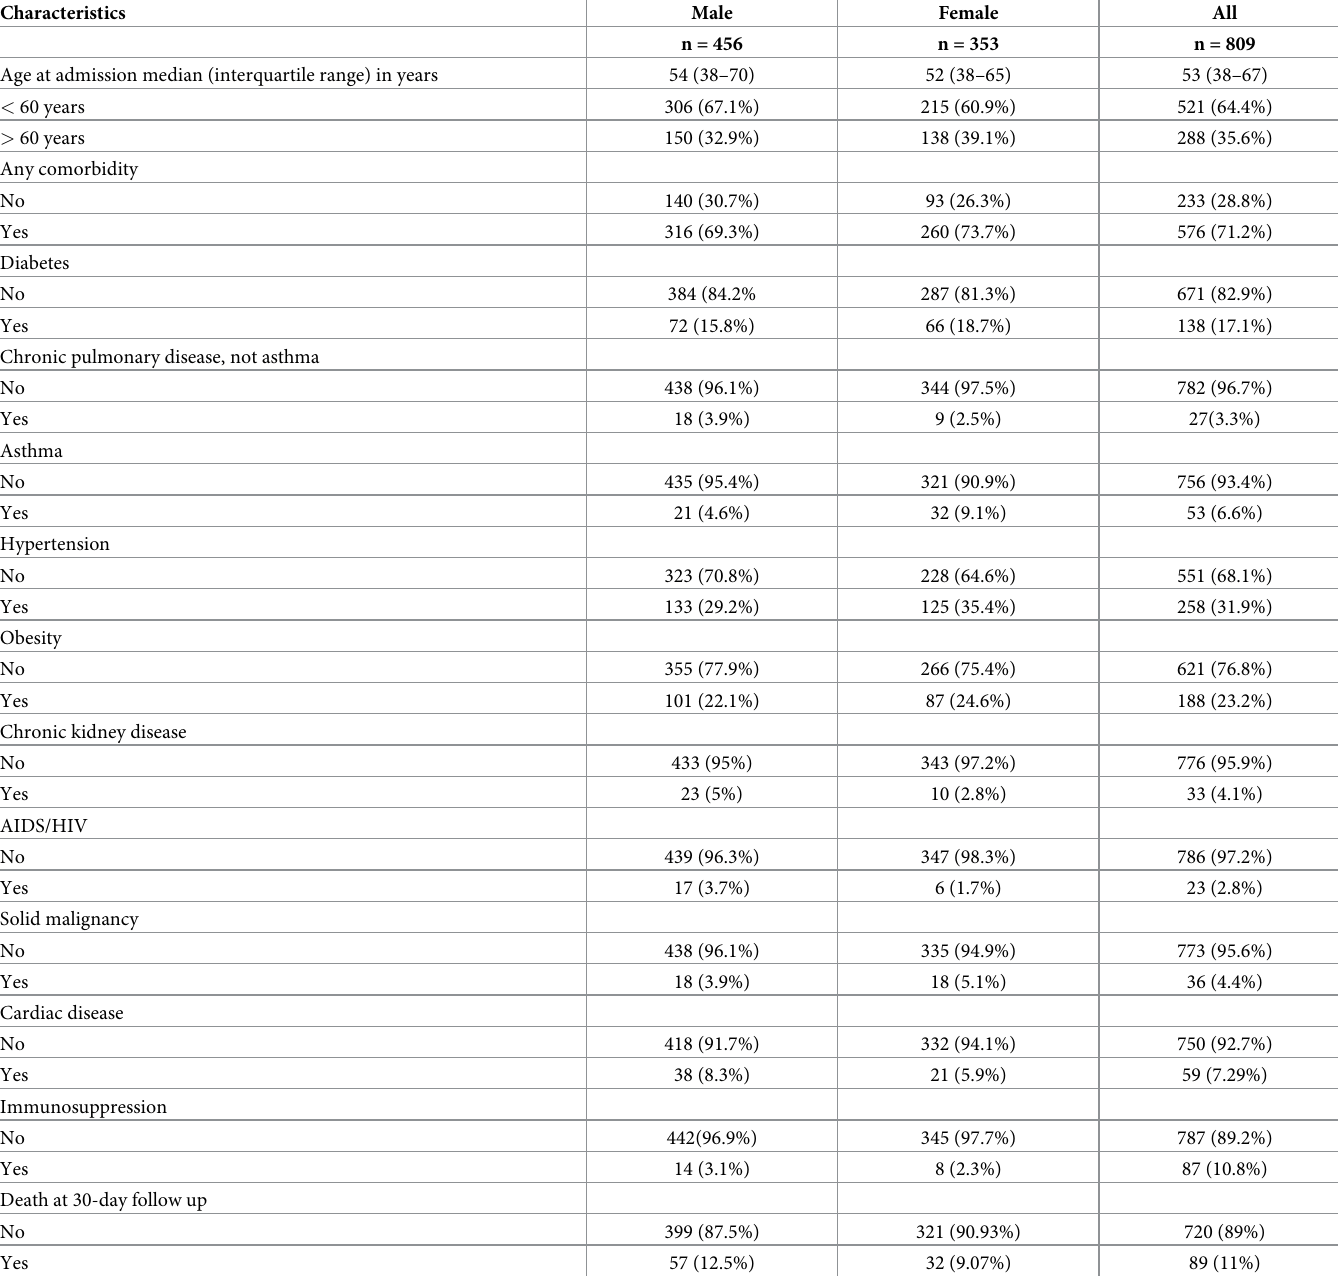
Table 1. Baseline characteristics among 809 hospitalized patients with COVID-19 in Argentina.